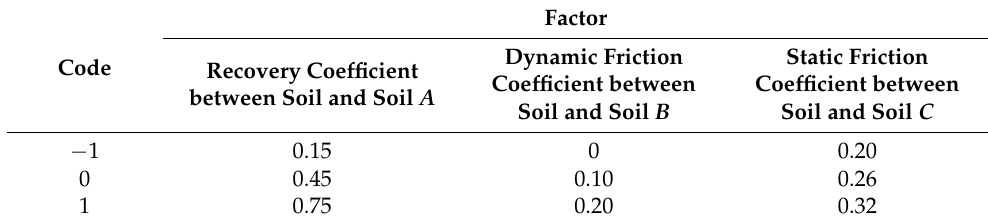
Table 3. Test factors and levels of soil repose angle calibration.